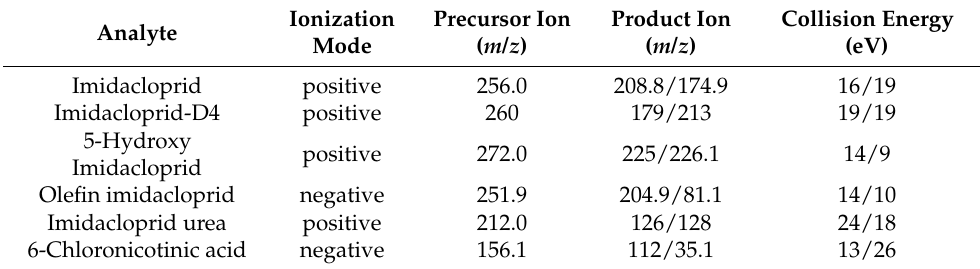
Table 5. MS parameters for imidacloprid and its